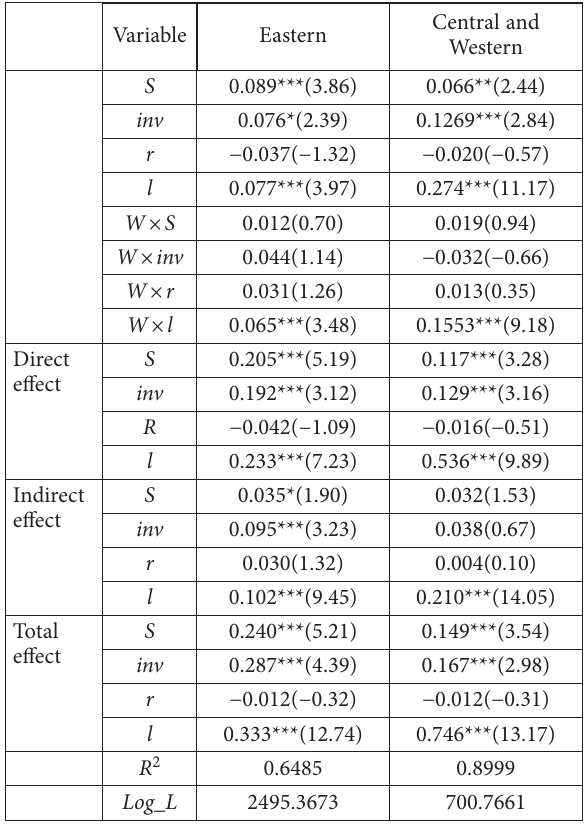
Table 8. Results of SDM for Eastern region and Central and Western regions Variable